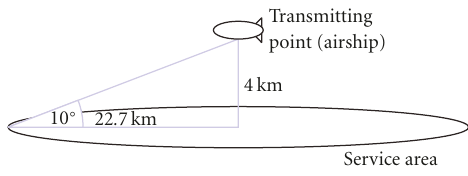
Figure 2: Illustration of the demonstration service area.